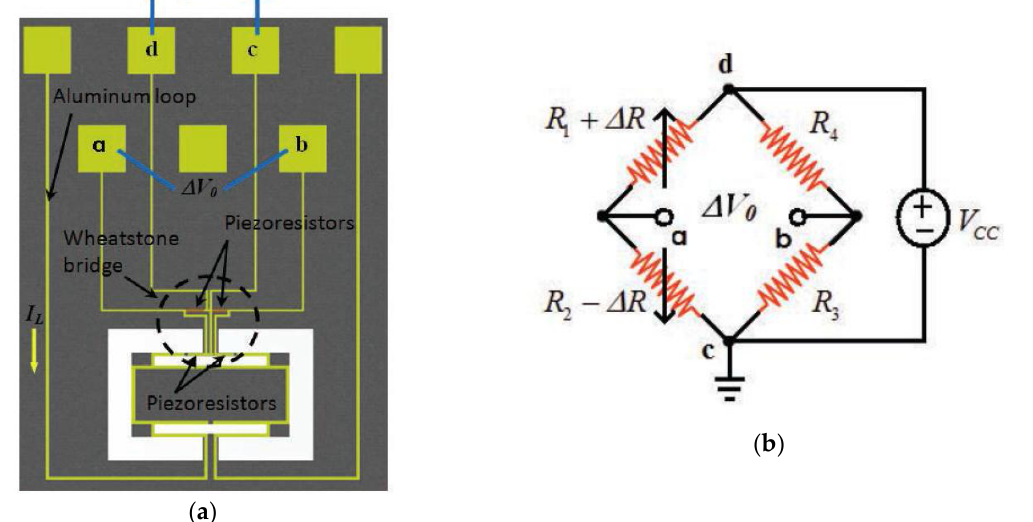
Figure 7. ( a ) Schematic view of a MEMS magnetic field sensor with ( b ) piezoresistive sensing through a Wheatstone bridge composed by four p-type piezoresistors [25]. Reprinted with permission from [25]. Copyright© 2015, IOP Publishing.